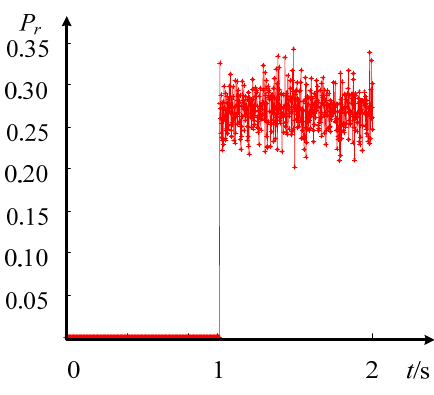
Figure 19. Bit error rate sequence.